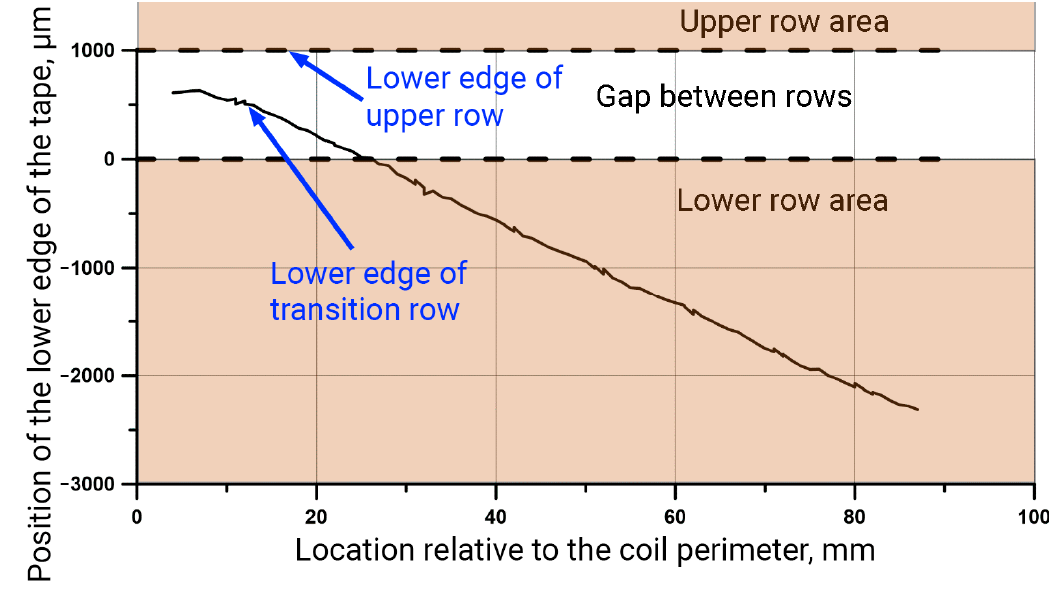
Figure 9. Coil #1 transition turn location.